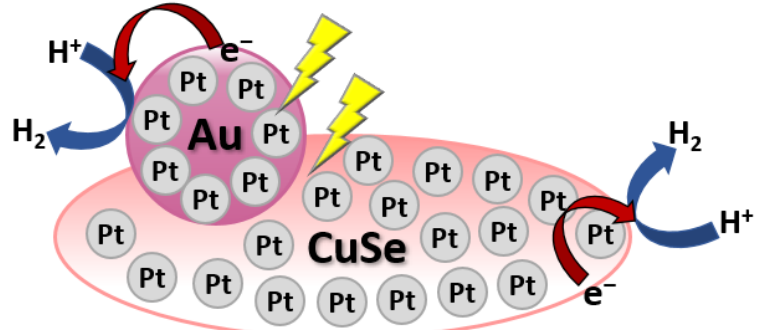
Figure 7. Schematic diagram of Au/CuSe/Pt ultrathin nanoplate hybrid for H 2 evolution under vis- ible and near-infrared irradiation.